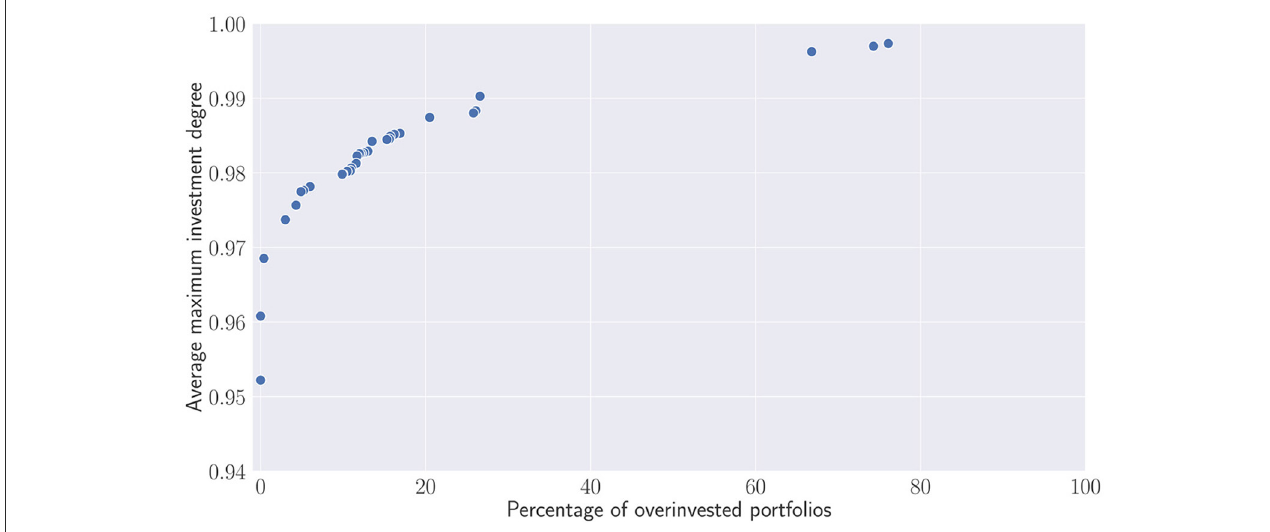
FIGURE9 Pareto set of recommitment strategies. Average maximum investment degree V.S. percentage of overinvested portfolios obtained after simulations.